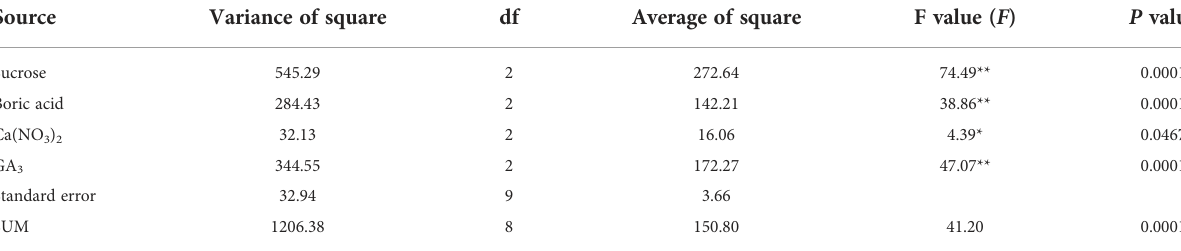
TABLE 3 ANOVA results for the effects of different media on pollen germination of E. racemosa.